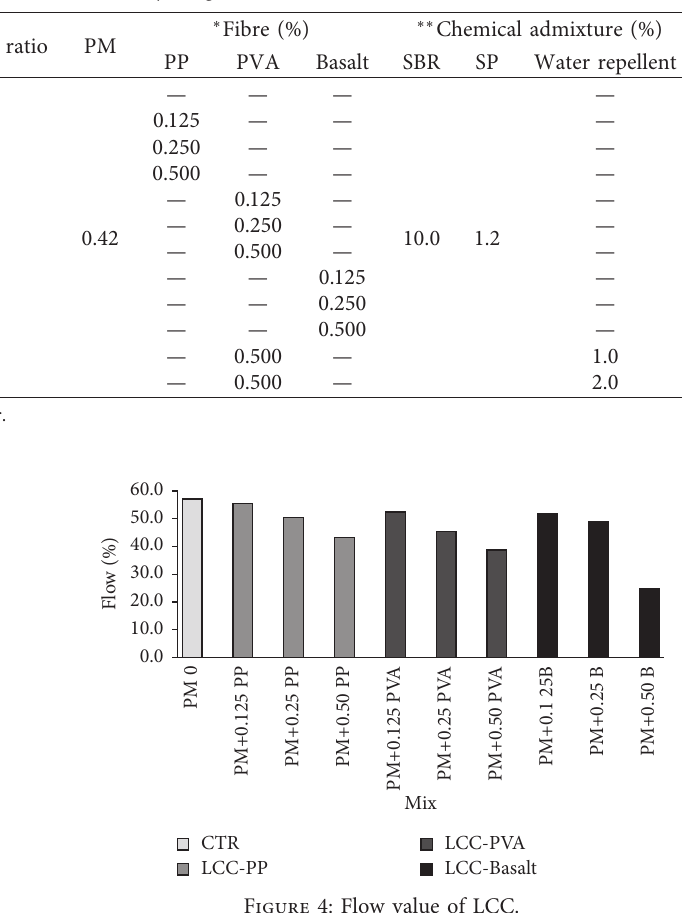
Table 2: Mixture proportions of LCC (by weight of binder).